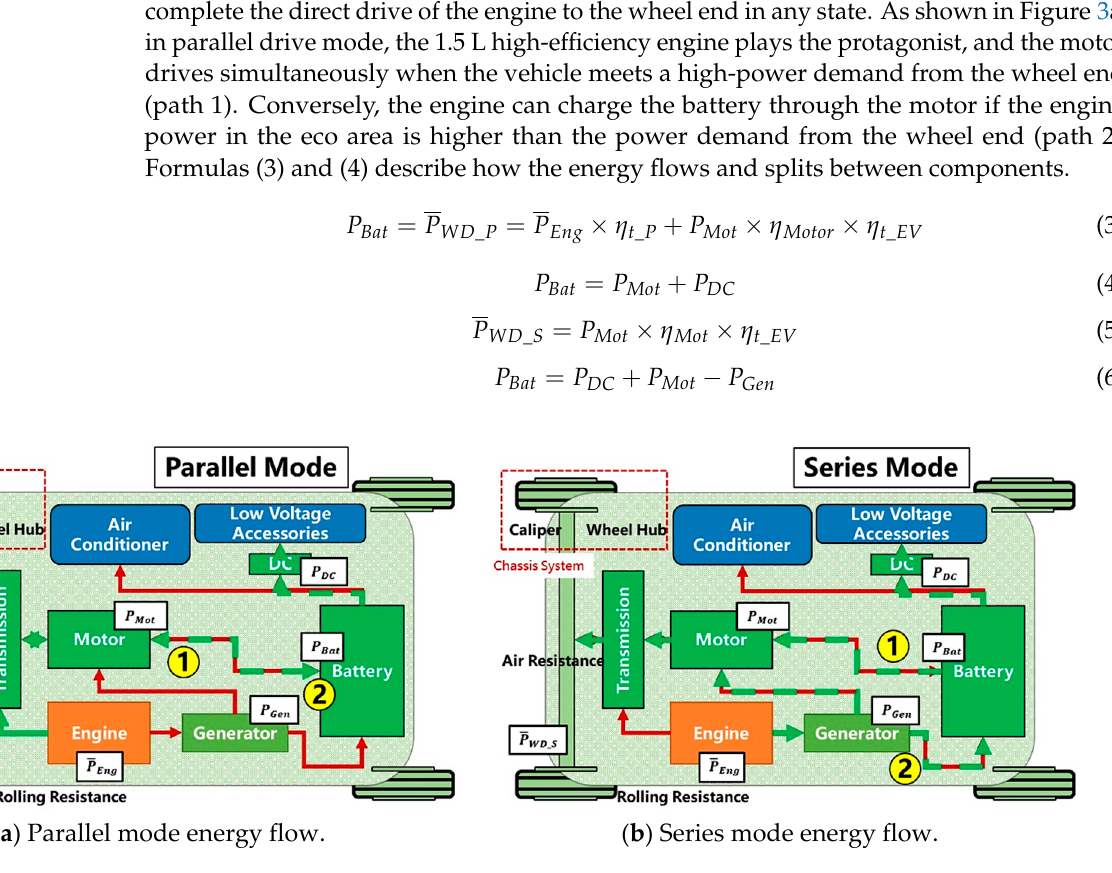
4 of 11 Figure 2. DMi EV modes.